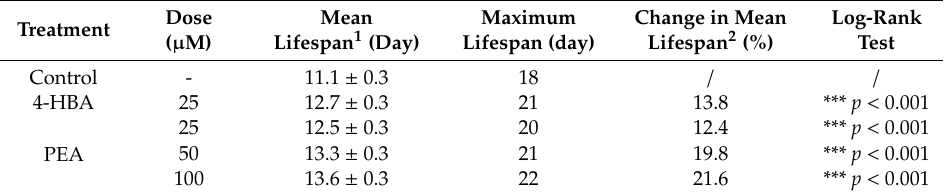
Figure 3. Longevity effects of PEA in wild-type N2 C. elegans at 25, 50, and 100 μ M. ( a ) The mortality of each group was determined daily by counting the dead animals. ( b ) The mean lifespan of the worms was calculated from the survival curves in (a). The bar graph represents the mean ± SEM of three independent experiments, and each group in the experiment consisted of 50 worms. Significance was determined by one-way ANOVA (*** p < 0.001). 4-HBA (4-hydroxybenzoic acid) was used as a positive control. Table 1. Effects of PEA on the lifespan of C. elegans.